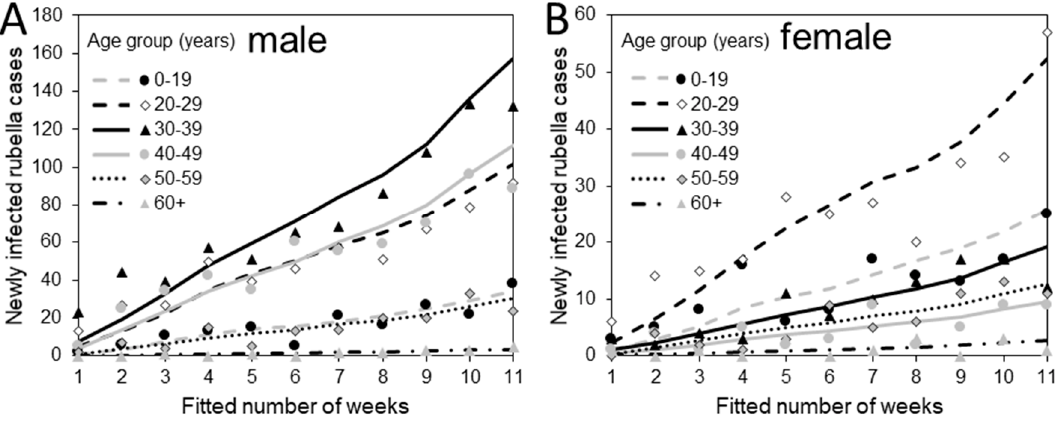
Figure 2. Comparisons between the observed and predicted weekly incidence of rubella by age and sex in Japan, 2013. ( A ) Comparisons between the observed and predicted weekly incidence of males and ( B ) females. Lines represent predictions that were derived from our multivariate renewal process model. Marks represent the observed data by age group.